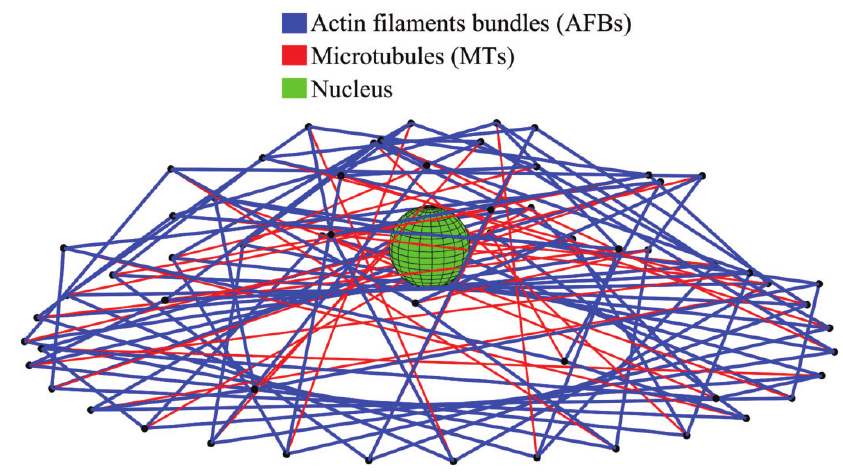
Figure 2. A ten-level tensegrity model within the HEK-293 cell’s contour.